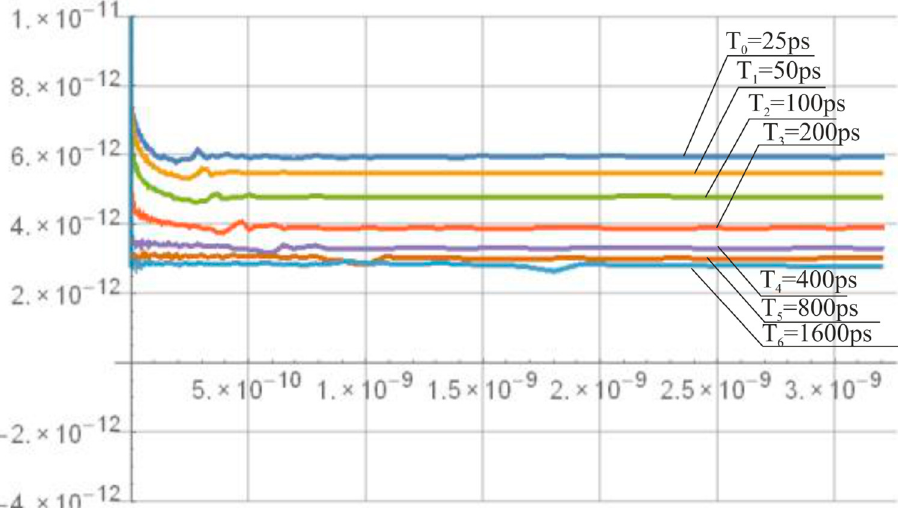
Figure 29. Differences of propagation delays of multiplexers S Si and S Ri vs. input time interval T In for 8-bit SA-TDC with T m = 250 ps evaluated for cells including various binary delays.